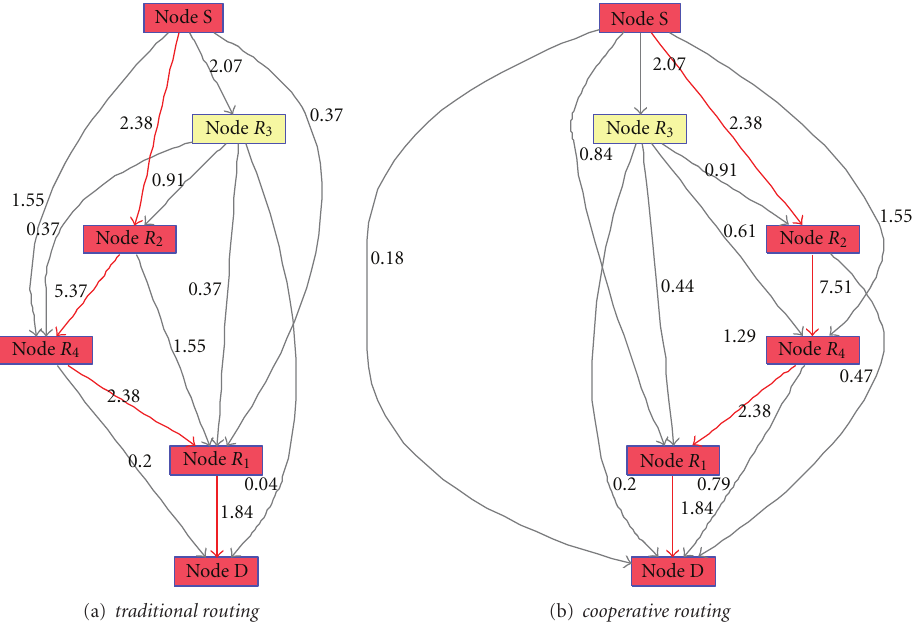
Figure 7: Routing for highest energy e ffi ciency.